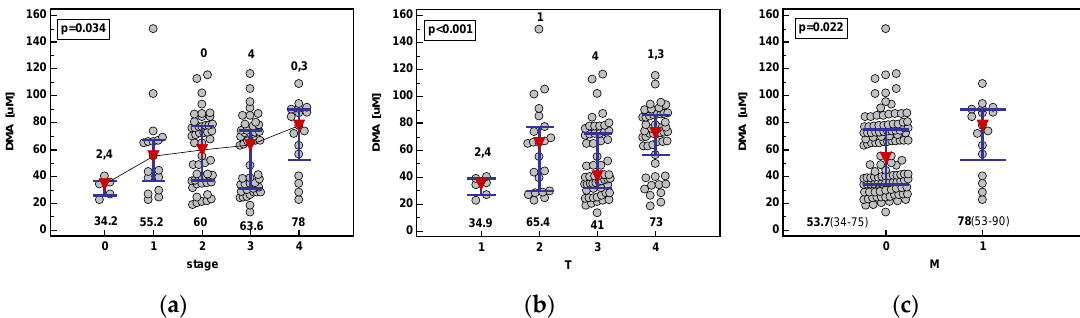
Figure 2. Association between dimethylamine (DMA) concentration and CRC advancement: ( a ) Overall tumor-node-metastasis (TNM) stage; ( b ) extent of primary tumor (T); ( c ) distant metastasis (M). Data presented as medians with an interquartile range and analyzed using the Kruskal-Wallis H test or Mann-Whitney U test (panel C). Statistically significant ( p < 0.05) differences between CRC stages (0–4) are denoted by numbers above the dot-plots.